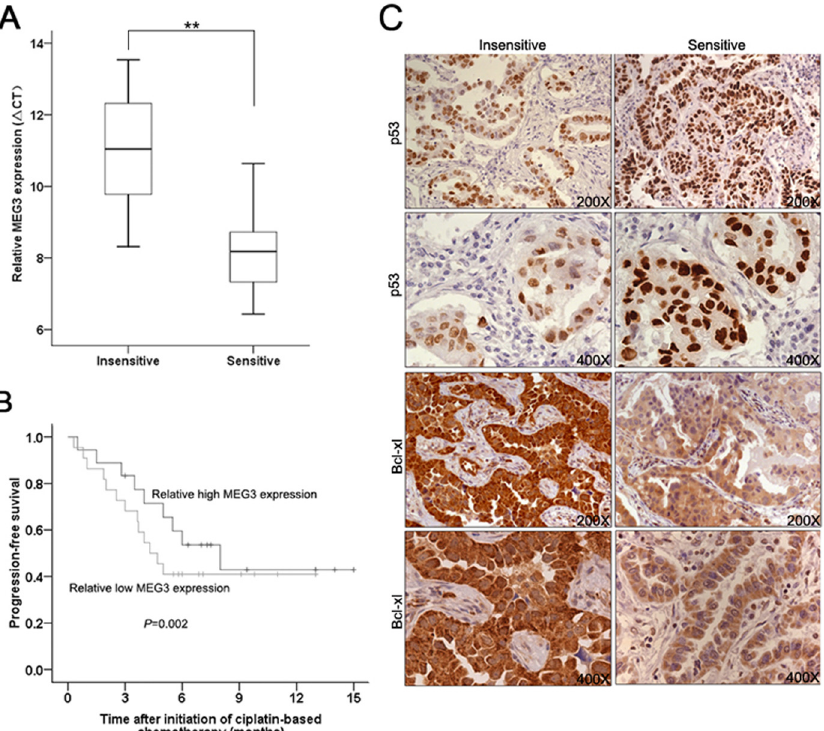
Fig 8. MEG3 expression levels are positively correlated with the responses of patients to cisplatin- based chemotherapy. (Fig 8A) qRT-PCR analysis of MEG3 expression levels in cisplatin-sensitive (n = 20) and cisplatin-insensitive (n = 21) LAD tissues. (Fig 8B) Kaplan – Meier survival analysis of the association between PFS of LAD patients and MEG3 expression (log rank P < 0.001). (Fig 8C) Cisplatin-sensitive tissues exhibited higher p53 and lower Bcl-xl protein expression than cisplatin-insensitive tissues. Original magnification, ×200 or ×400. ** P < 0.01.